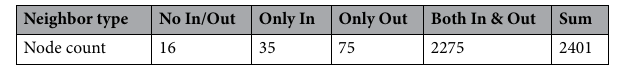
Table 5. Node counts based on their neighbor types.